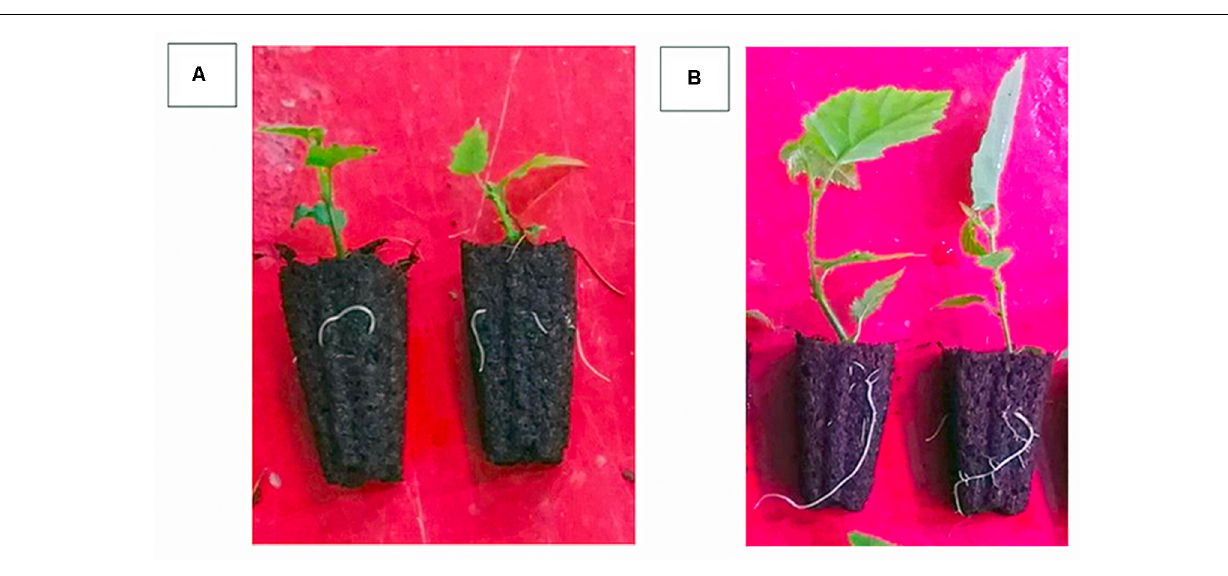
FIGURE 12 | Effect of different auxin treatments on morphology of Corylus avellana L. cv. “Fertile de Coutard” roots. (A) IBA-K (3 µ M); (B) diluted IAA-E C1 solution (IAA = 1 µ